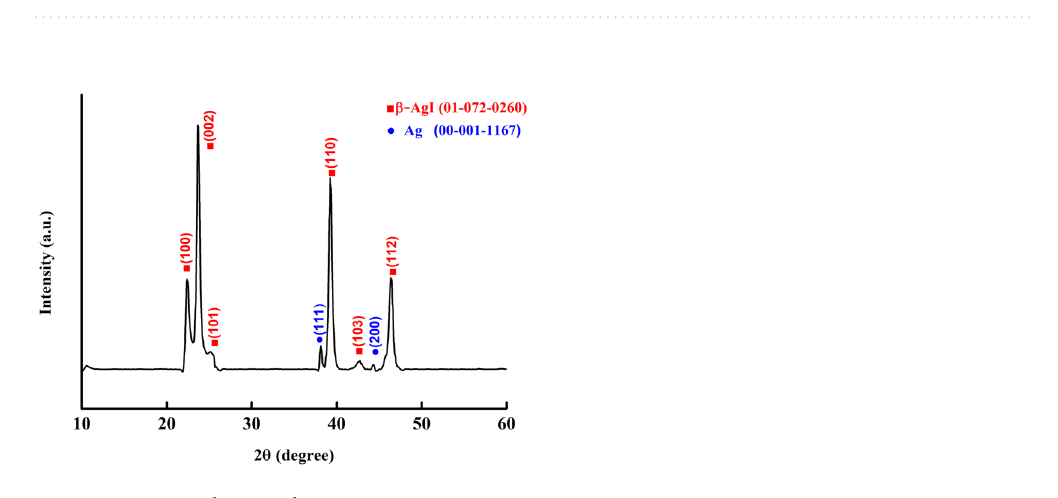
Figure 6. XRD analysis